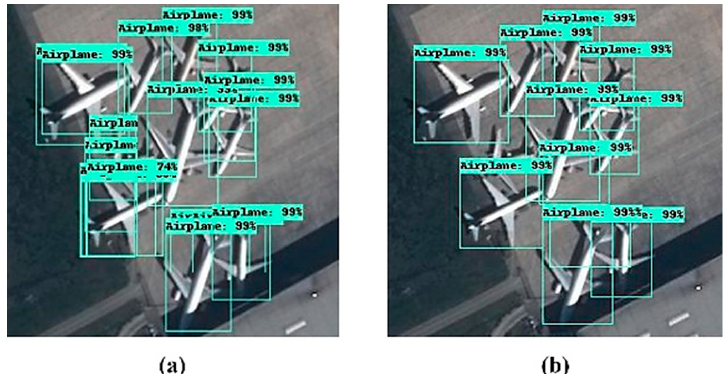
Figure 7. Detection results of occluded objects ( a ) Without the NMS algorithm, ( b ) With the NMS algorithm.